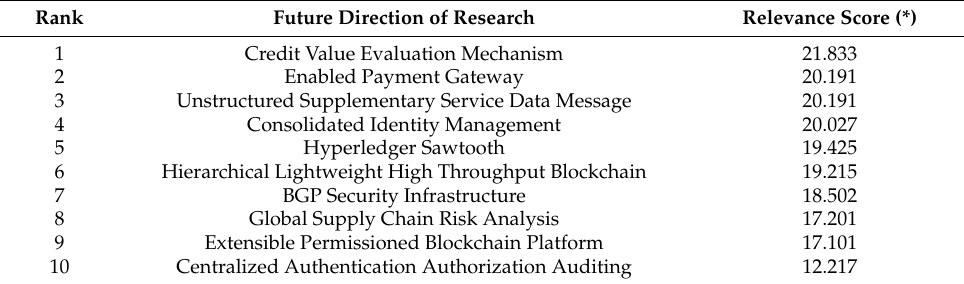
Table 11. Top 10 Future Directions of Research according to Relevance